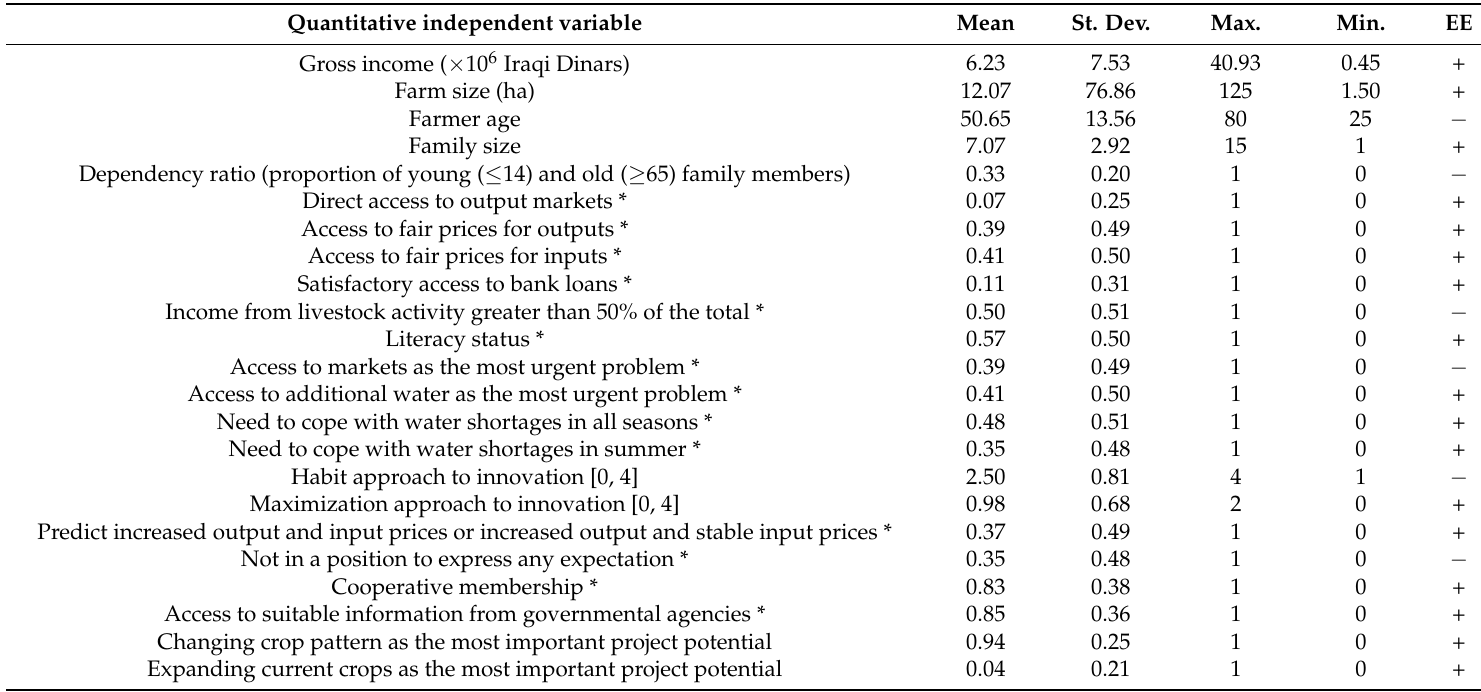
Table 5. Statistics of quantitative independent variables: * indicates a dummy variable, 1 means yes. EE, expected effects on adoption (+ = increase, − = decrease), according to the econometric